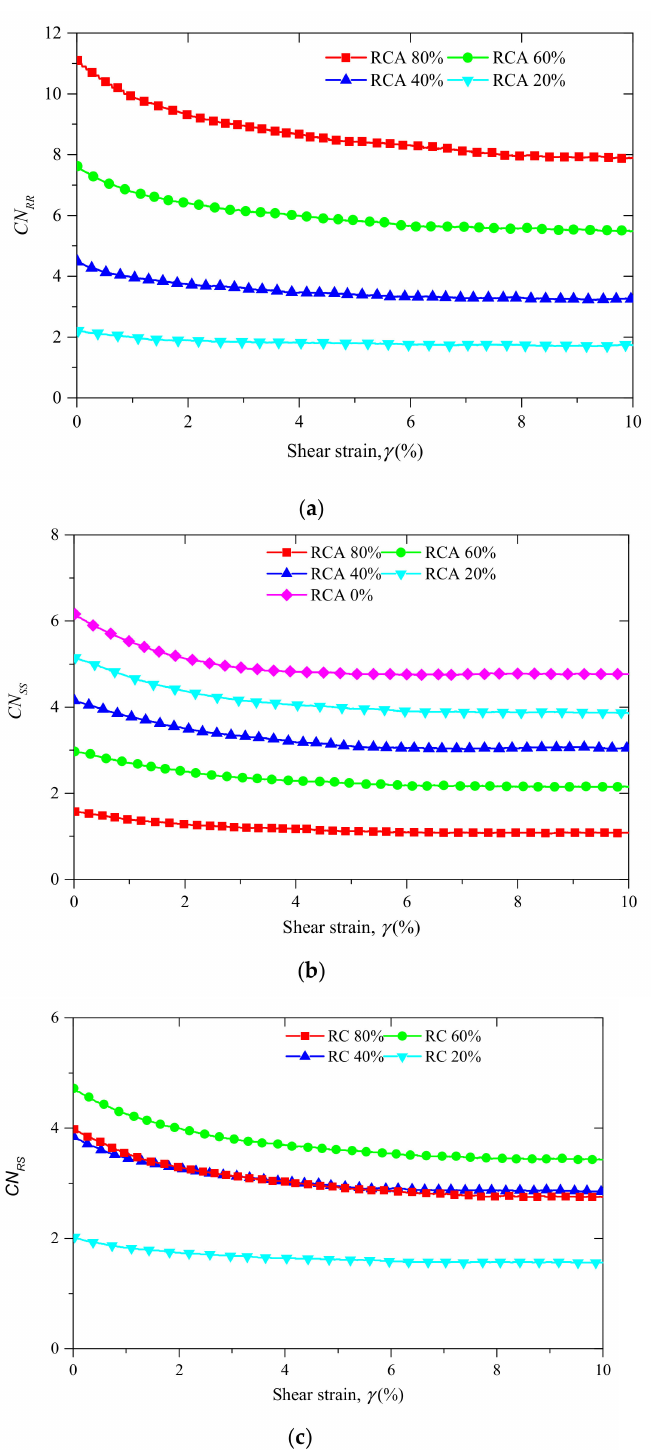
Figure 11. The evolutions of coordination numbers for samples with different RCA contents under confining stress of 200 kPa: ( a ) RCA–RCA contacts; ( b ) RCA–sand contacts; and ( c ) sand–sand